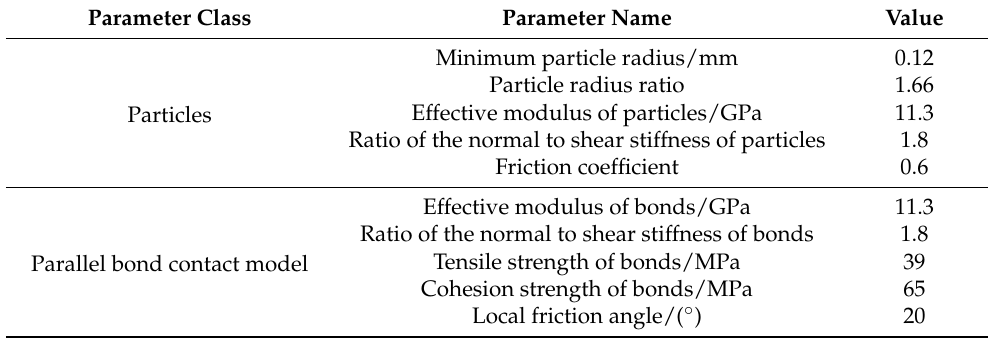
Table 3. Meso-mechanical parameters of granite matrix after corrosion by mud acid